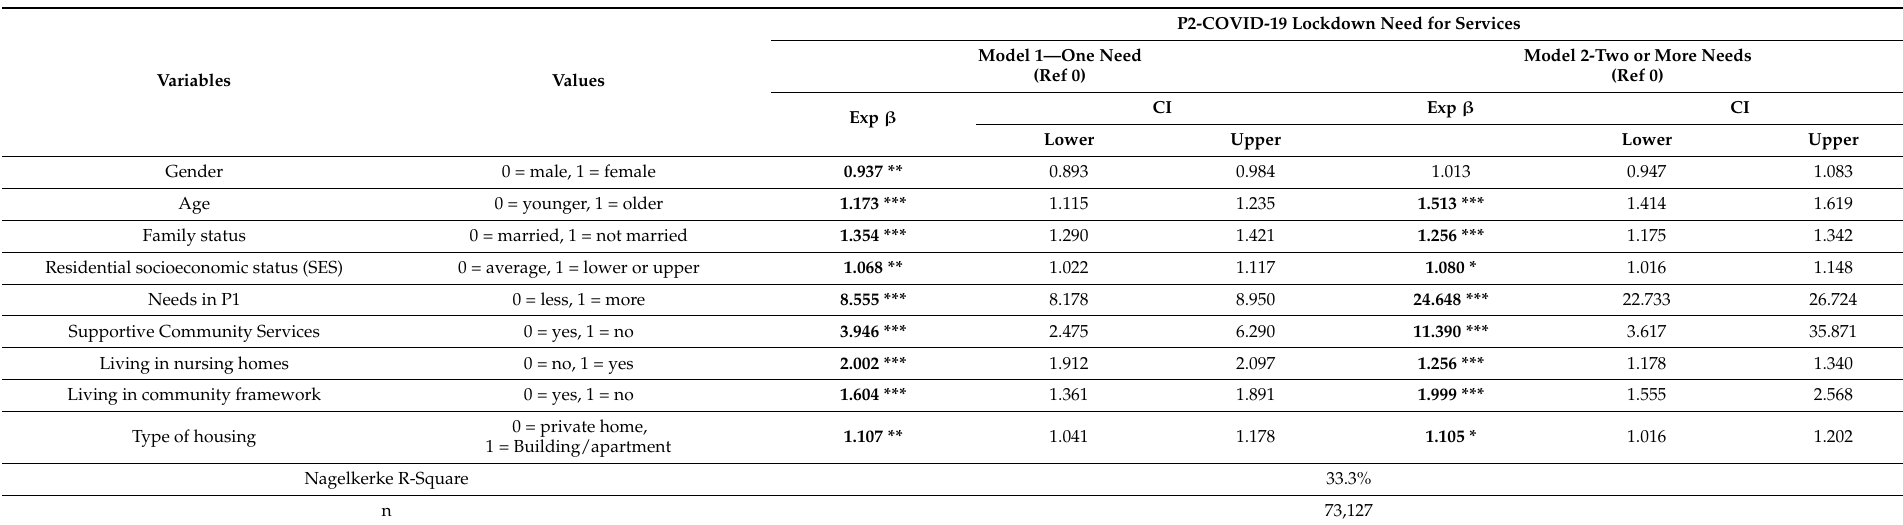
Table 3. Multi-nominal logistic regression to predict need for services during COVID-19 lockdown periods.